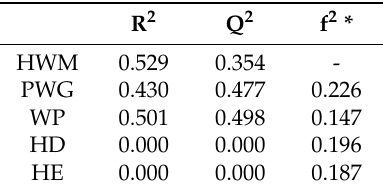
Table 6. Value of endogenous